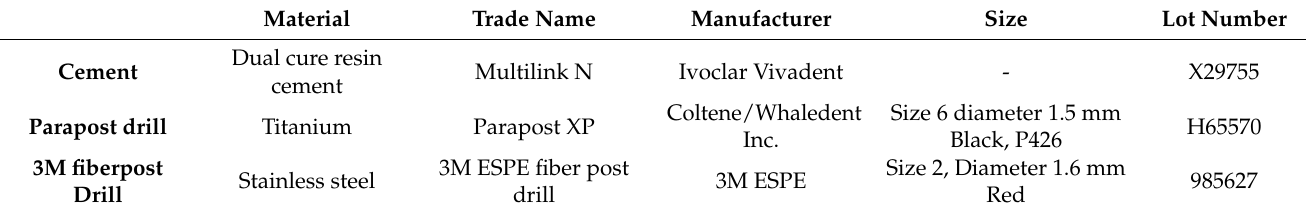
Table 2. Details of the materials and instruments used for preparation of the